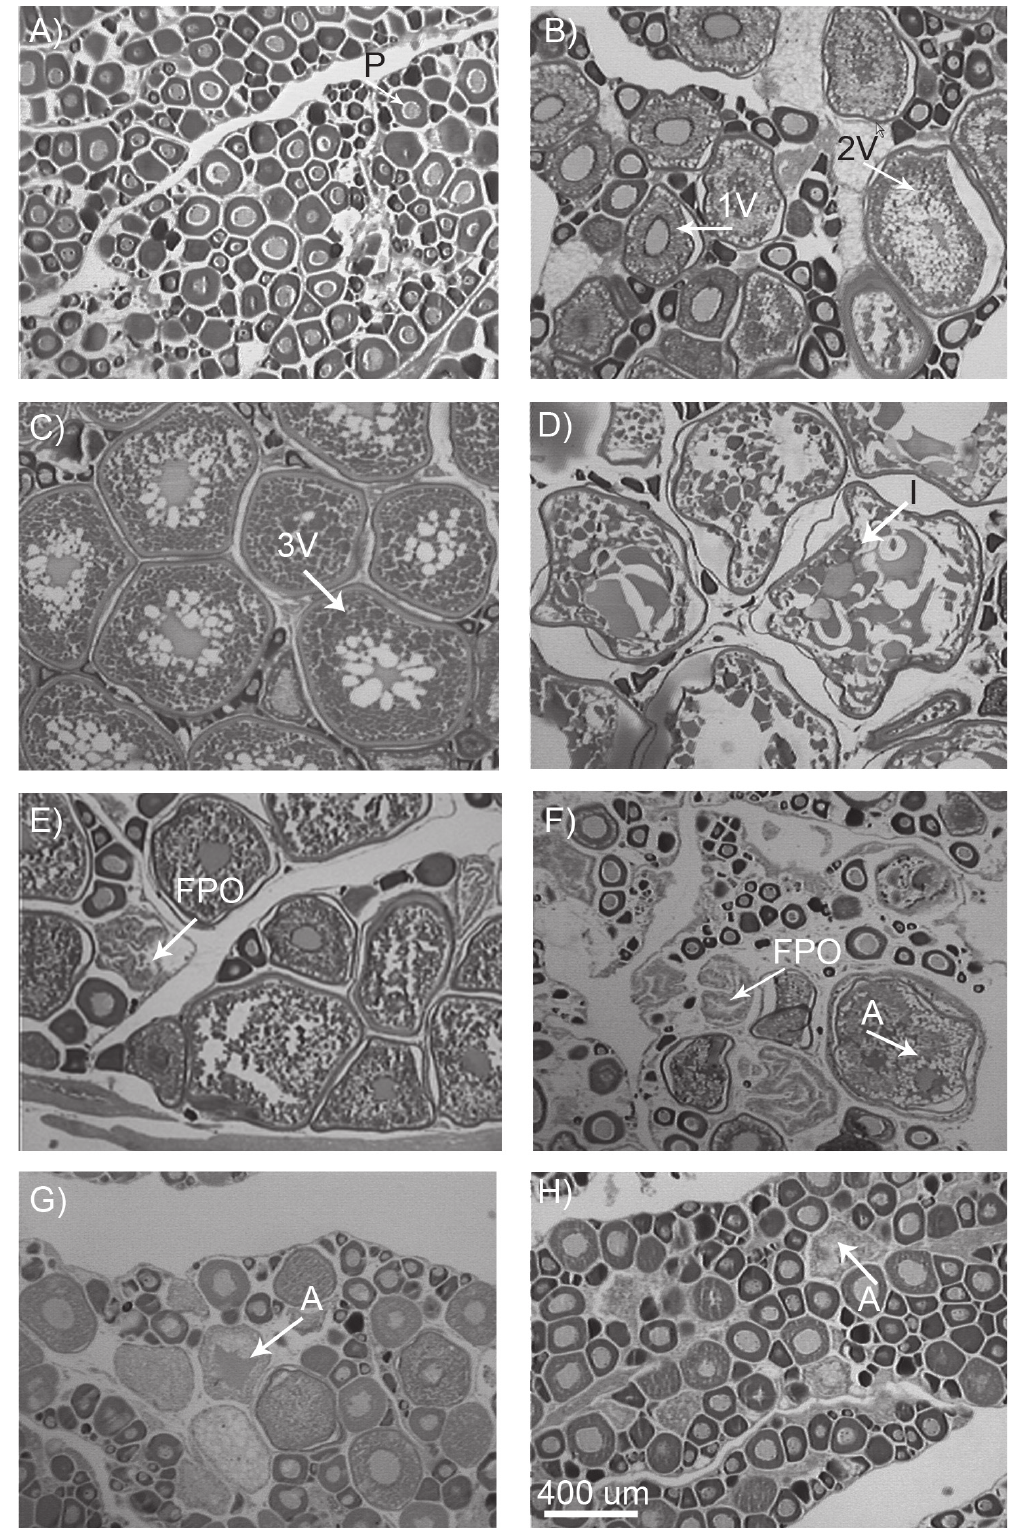
Fig . 2. – Histological sections of ovaries of Merluccius merluccius in different maturity stages. A) stage I, immature; B) stage II, in maturation; C) stage III, prespawning; D) stage IV, spawning; E) stage II+, partial postspawning; F) stage V, total postspawning; G) stage VI, regression; H) stage VII, resting (P = previtellogenic oocytes; 1V, 2V, 3V = 1 st ,2 nd ,3 rd vitellogenic stages; I = Hydrated oocytes; POF = postovulatory follicles; A = atretic